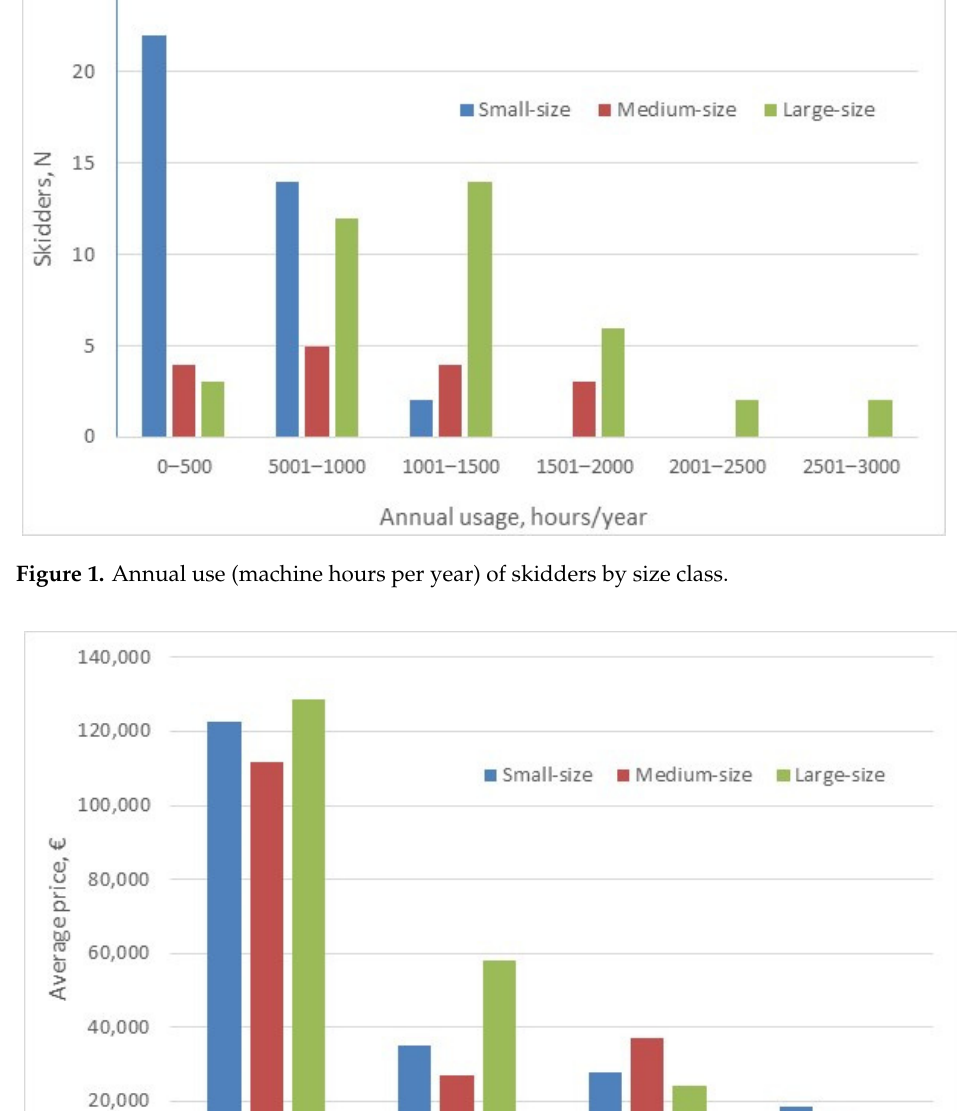
Figure 1. Annual use (machine hours per year) of skidders by size class.